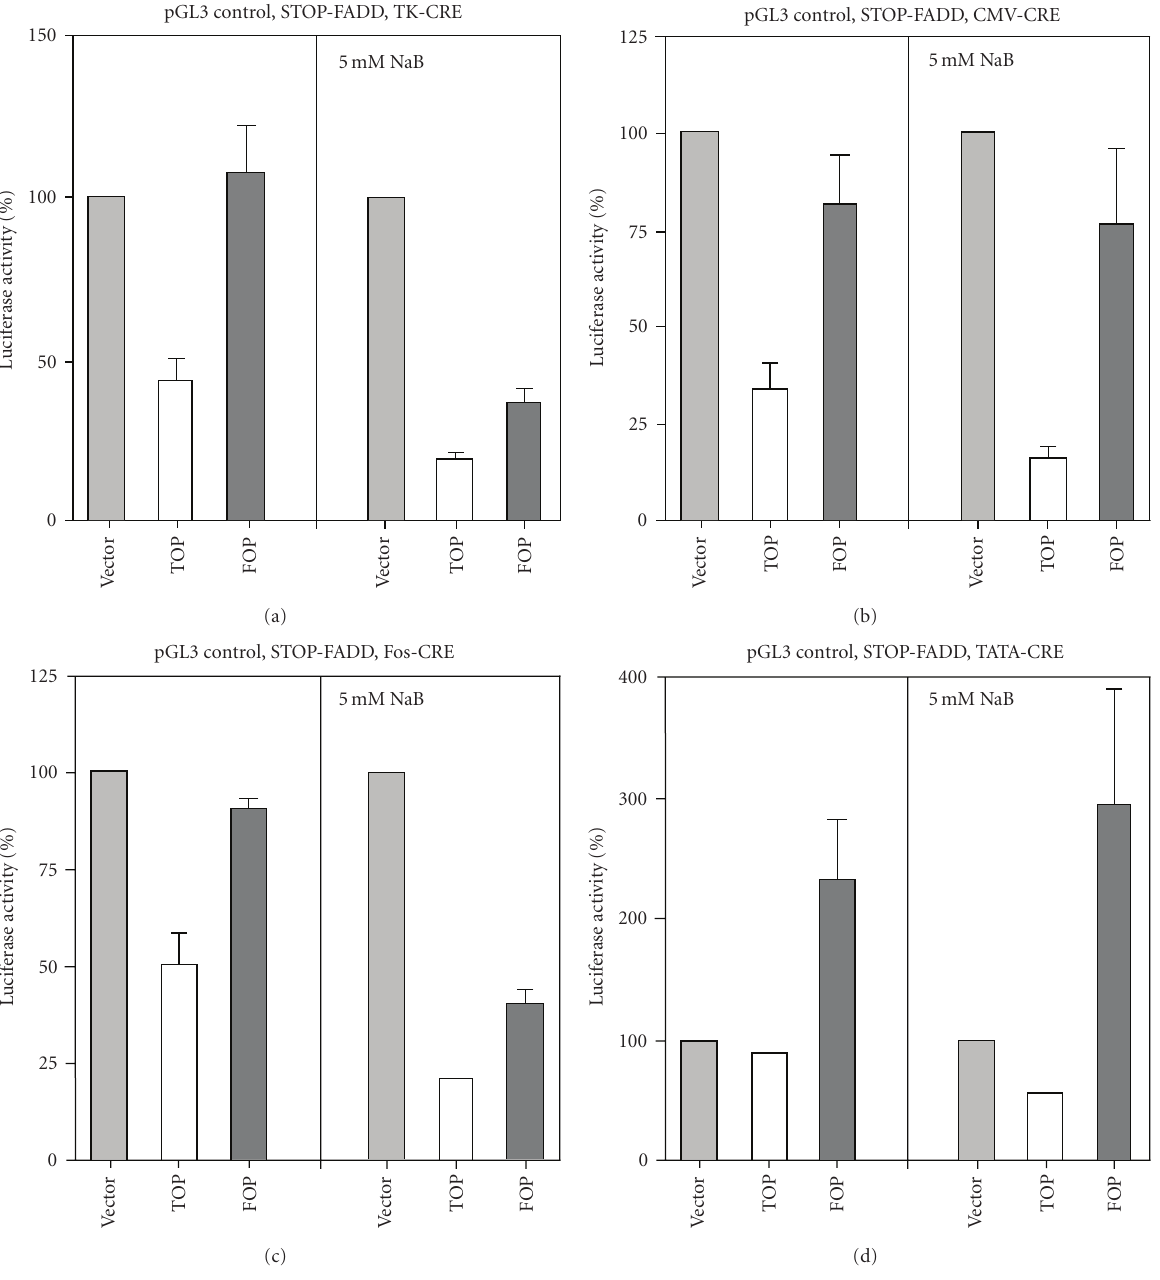
Figure 3: Wnt-specific SW620 cell kill. SW620 cells in a 24-well plate were transfected with 0.05 μ g of pGL3-Ctl, 0.5 μ g of STOP-FADD, and (a) 0.05 μ g of TOP/FOPTK-CRE, (b) 0.0067 μ g of TOP/FOPCMV-CRE, (c) 0.1 μ g of TOP/FOPFos-CRE, or (d) 0.15 μ g of TOP/FOPTATA- CRE, with equivalent amounts of the 0-CRE control expression vector per well, and untreated or treated with 5 mM butyrate, and assayed for luciferase expression 48 hours later. Luciferase readings were normalized to protein concentration determined for each sample. The input plasmids for each experiment are listed at the top of each graph. Results are from three independent experiments. Bars indicate standard deviations, reproduced as per copyright agreement from